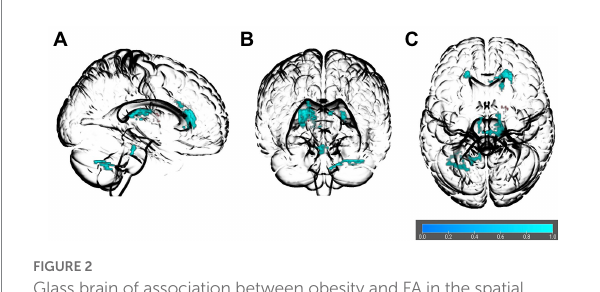
FIGURE 2 Glass brain of association between obesity and FA in the spatial voxel-based meta-analysis results. The orientations are (A) right sagittal, (B) anterior coronal, and (C) superior axial. Colored bar indicates values of 1–